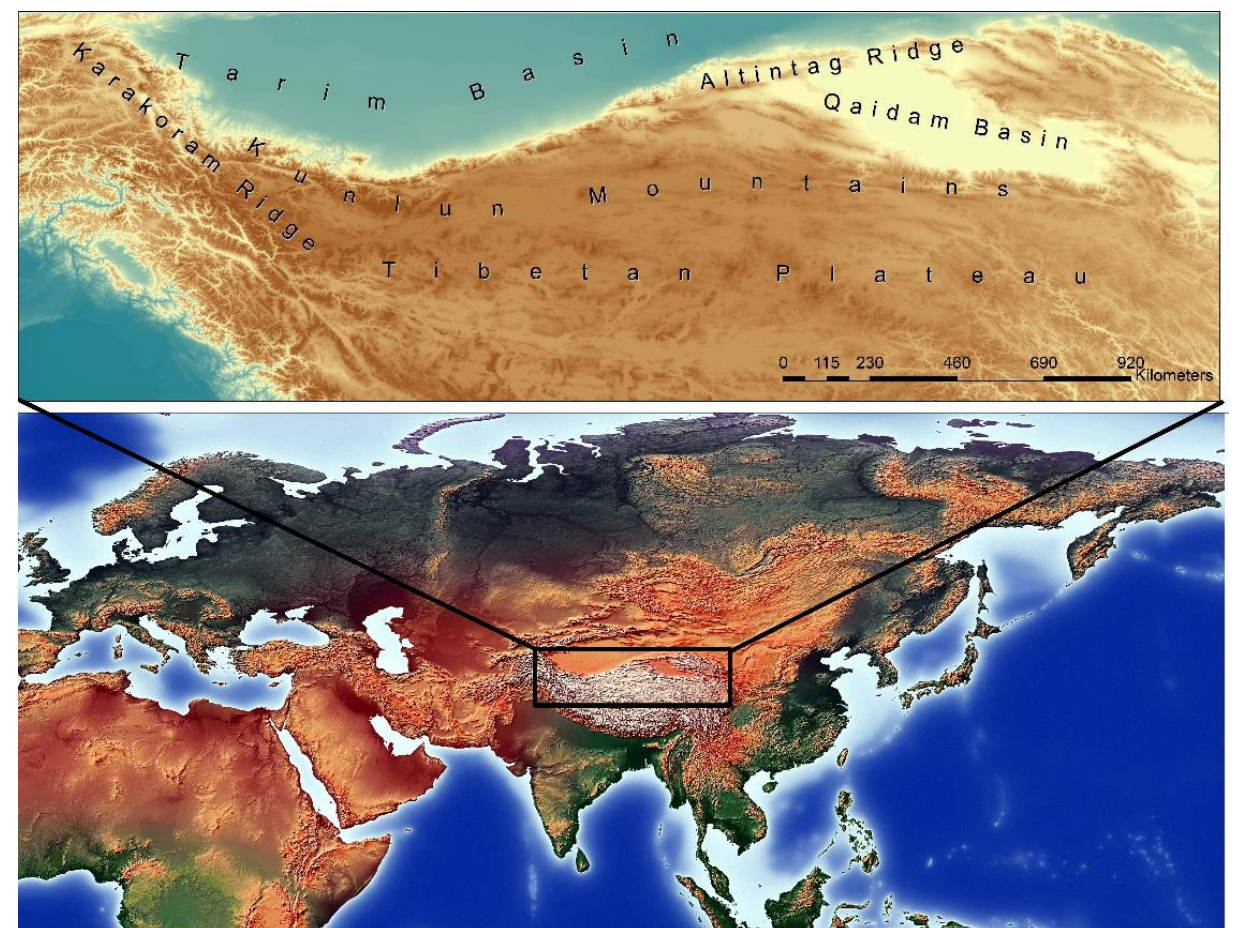
Figure 1. Schematic map of the Kunlun Mountains (the data compilation includes data from [30].